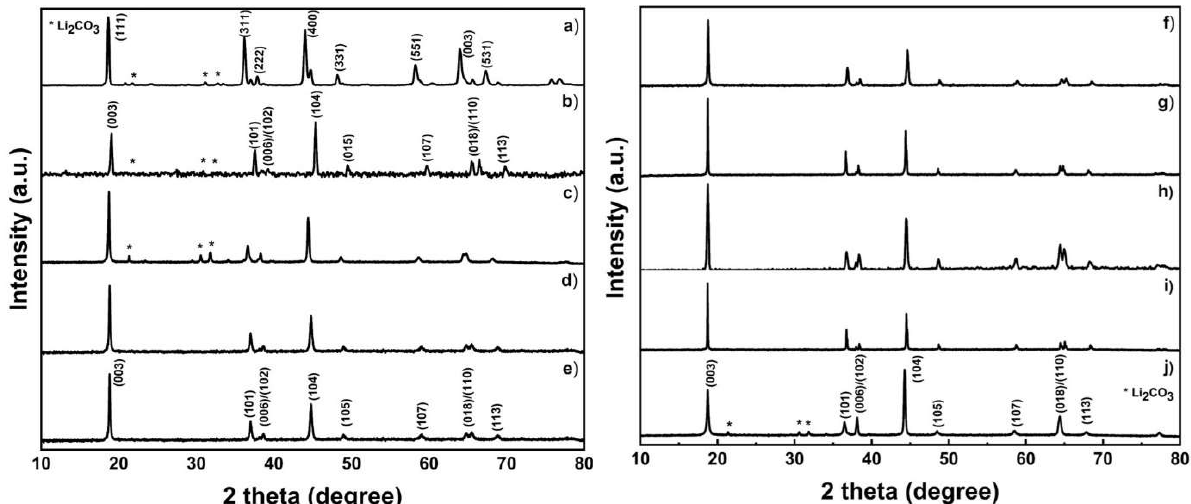
Figure 4. X-ray Diffractometer (XRD) patterns of the sample; ( a ) LMO, ( b ) LCO, ( c ) NMC 333, ( d ) NMC424, ( e ) NMC442, ( f ) NMC523, ( g ) NMC532, ( h ) NMC 622, ( i ) NMC 811, and ( j ) NMC 811.